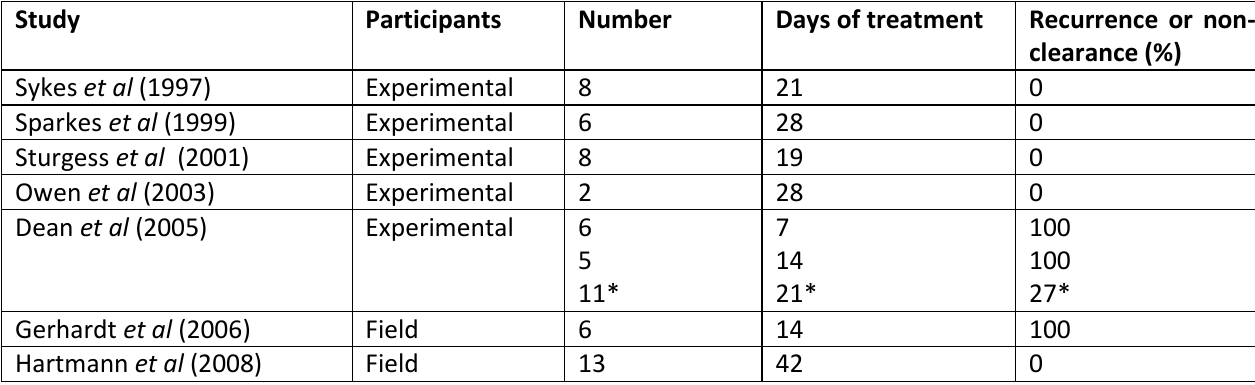
Table 1: * = these cats had received either 7 or 14 day courses before the 21 day course. The 3/11 cats (27%) which recurred after 21 day treatment cleared infection with a subsequent 28-day course. The evidence available indicates that a 14-day course is insufficient, whilst a 21-day course may be sufficient